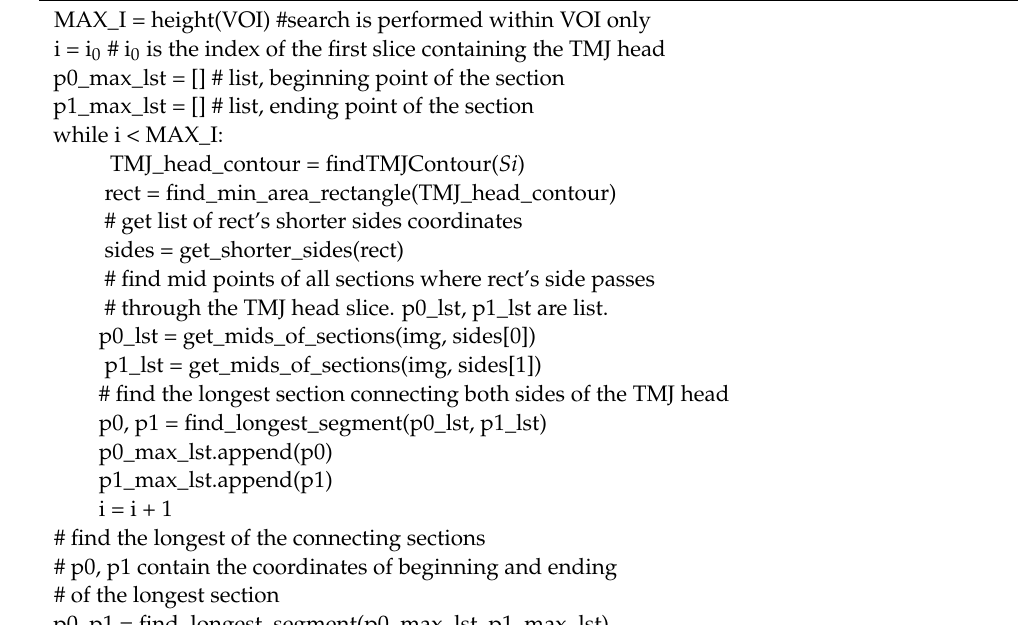
Algorithm 1. The longest section search